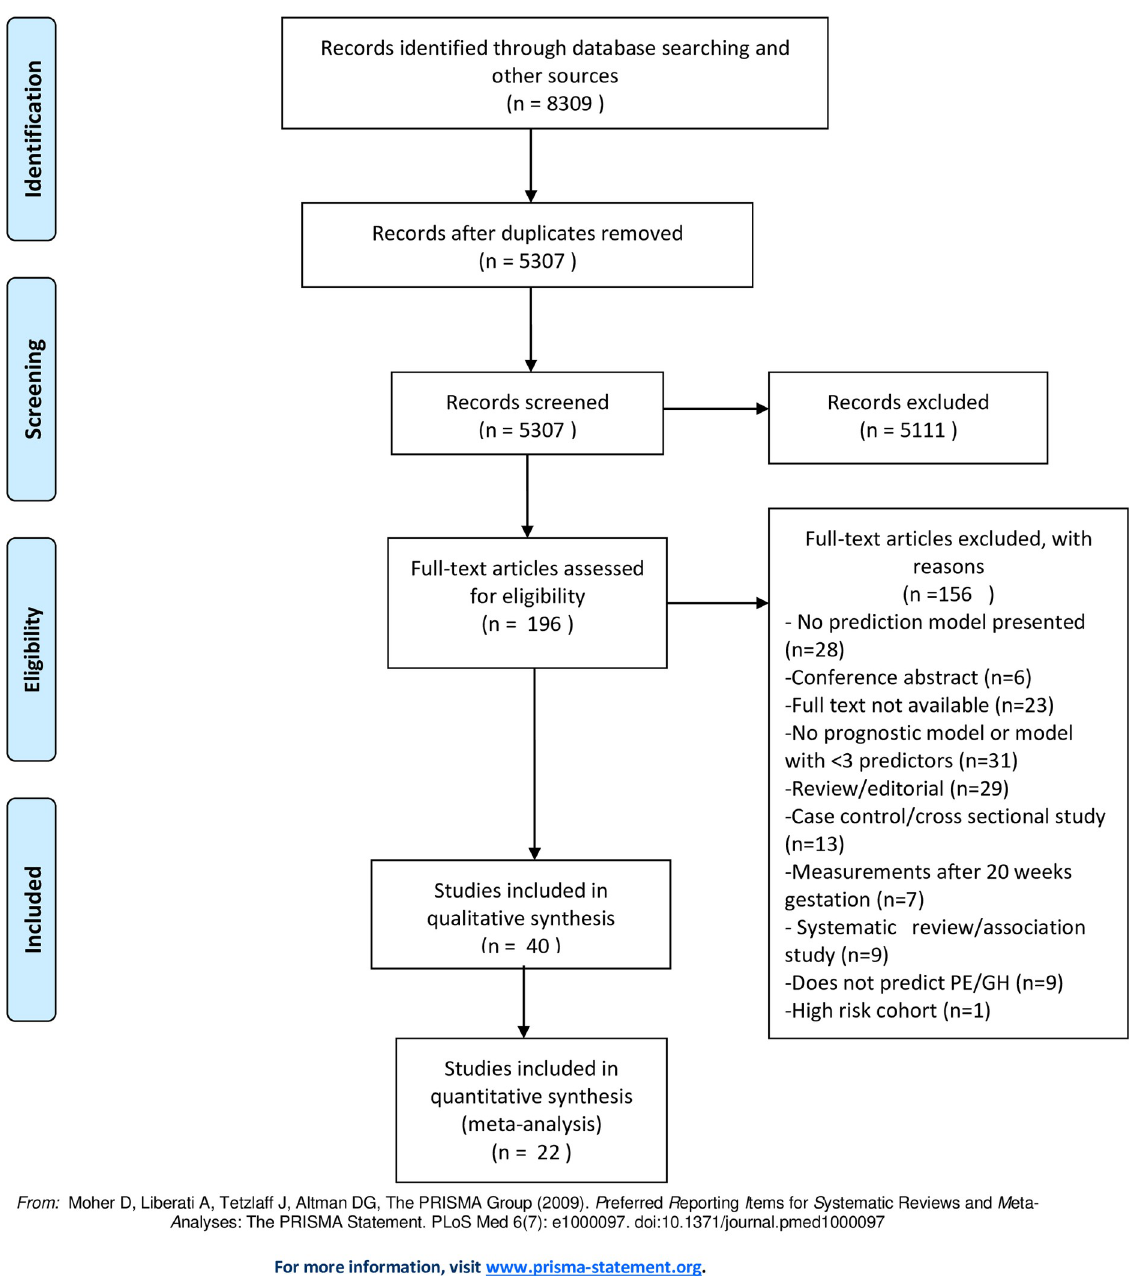
Fig 1. Flow diagram for inclusion and exclusion of relevant